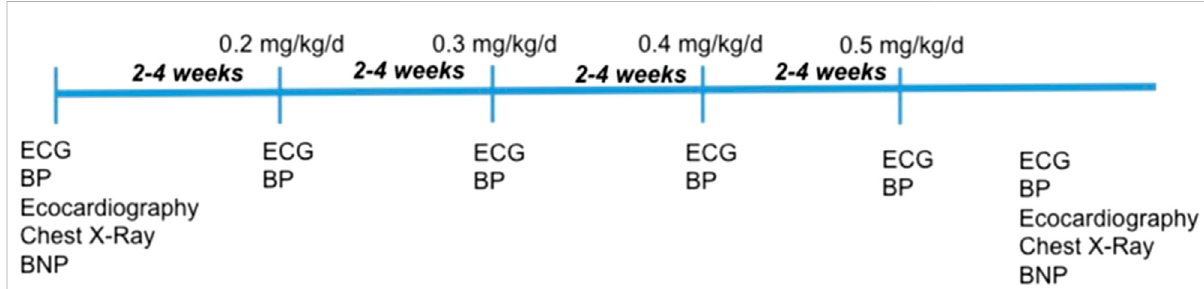
FIGURE 1 Uptitration of carvedilol during the follow up. Each dose was uptitrated every 2 – 4 weeks. ECG: electrocardiogram; BP: Blood Pressure.